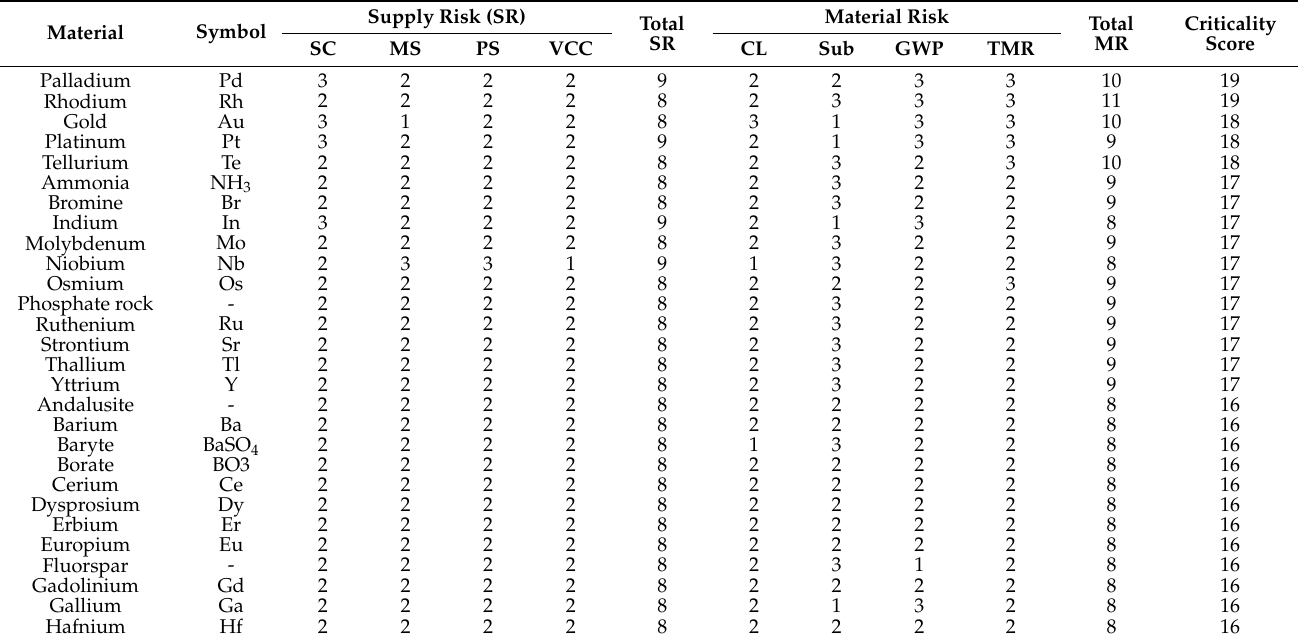
Table 5. Extracted top 28 Critical Materials list for